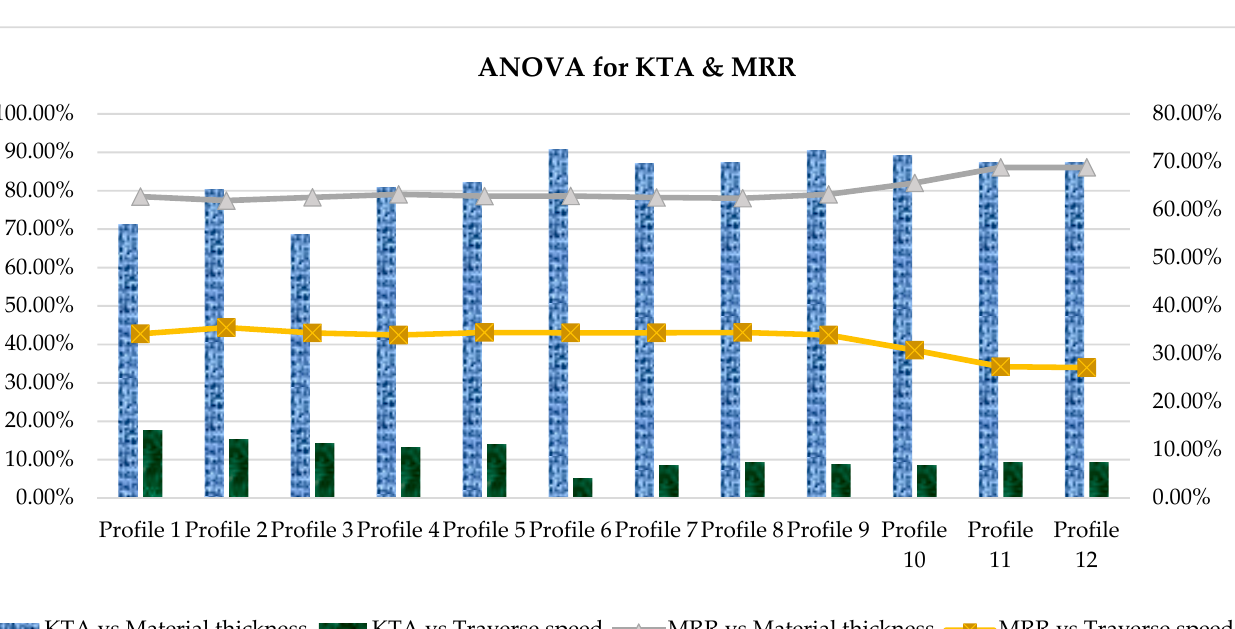
Figure 8. ANOVA results of KTA and MRR for AWJ contour cutting of AISI 304L with varied thickness.